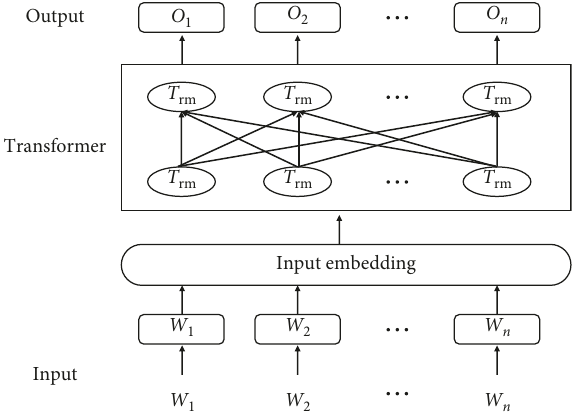
Figure 1: BERT model